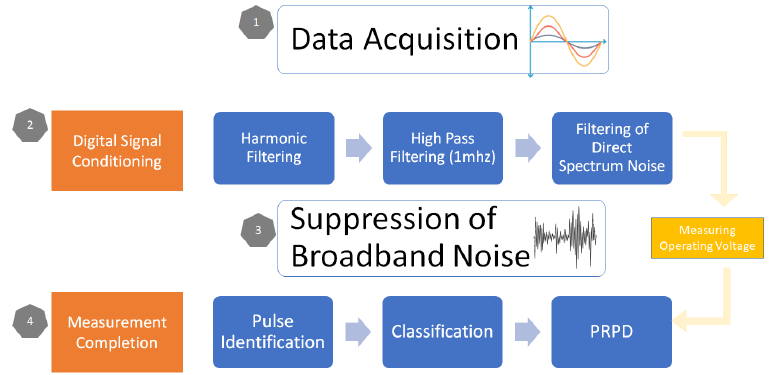
Figure 4. Digital processing of PD signals.